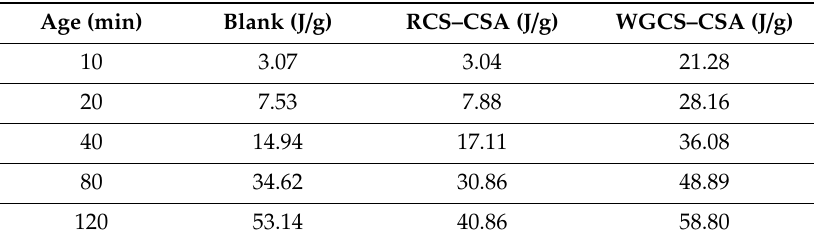
Table 5. Accumulated hydration heat of CS–CSA pastes from 10 to 120 min.